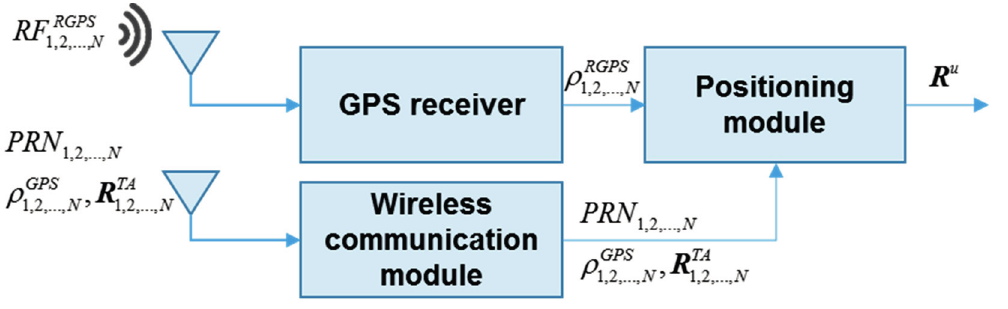
Figure 4. Architecture of the user